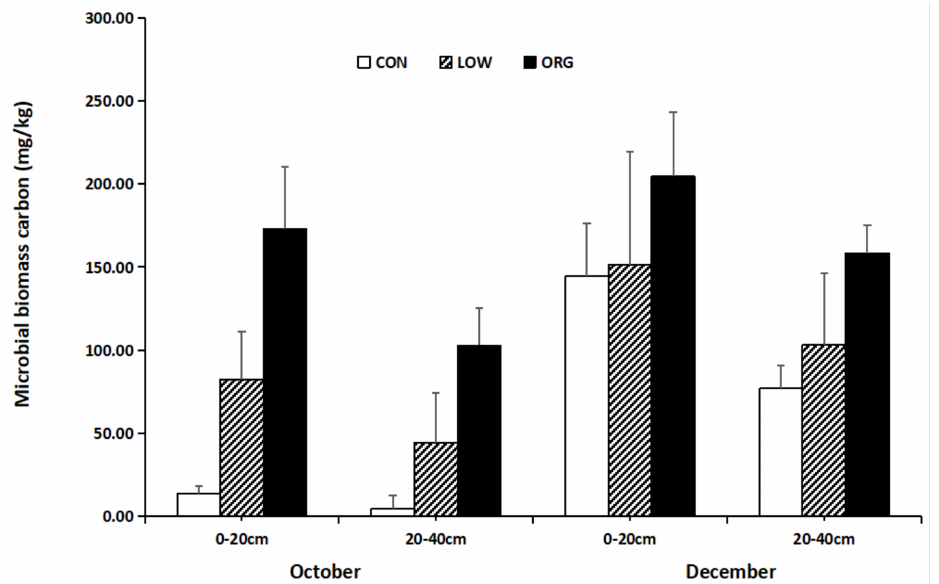
Figure 1. Effect of conventional, low-input, and organic practices on soil microbial biomass